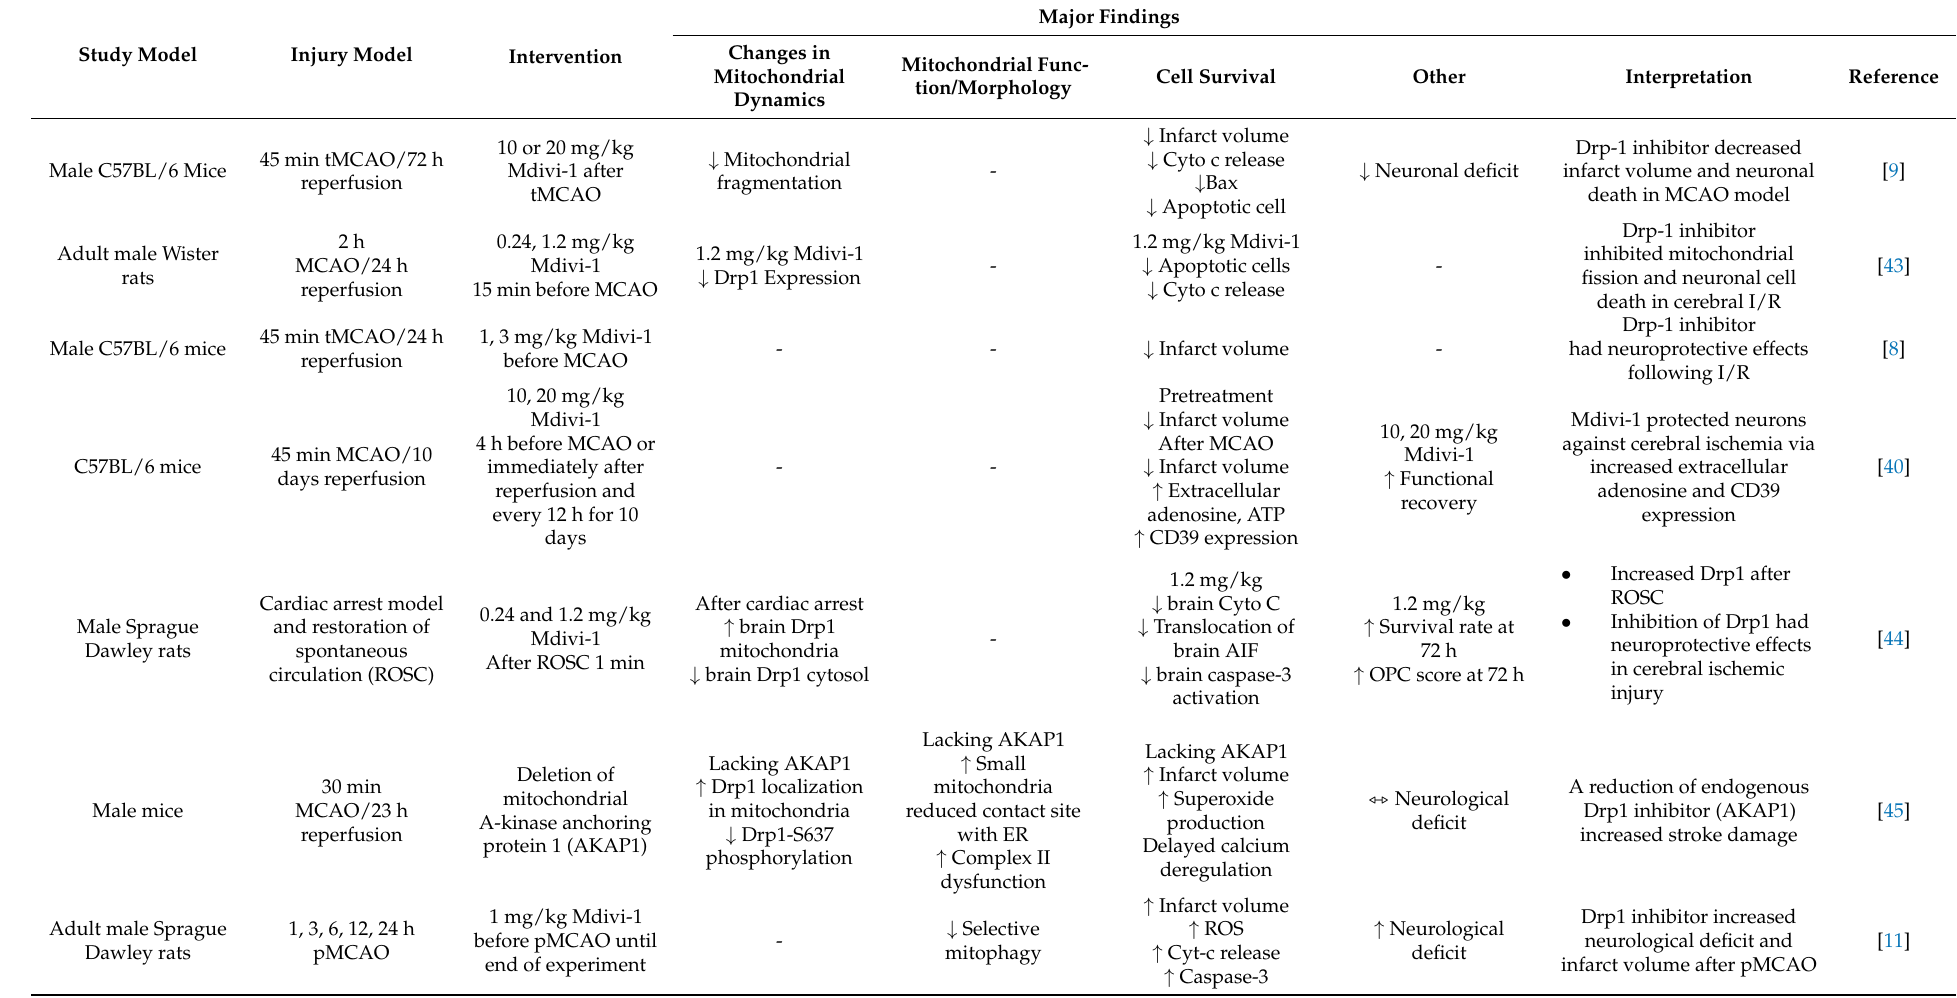
Table 4. Evidence in the interventions for the alterations in mitochondrial dynamics following cerebral ischemia/reperfusion: in vivo